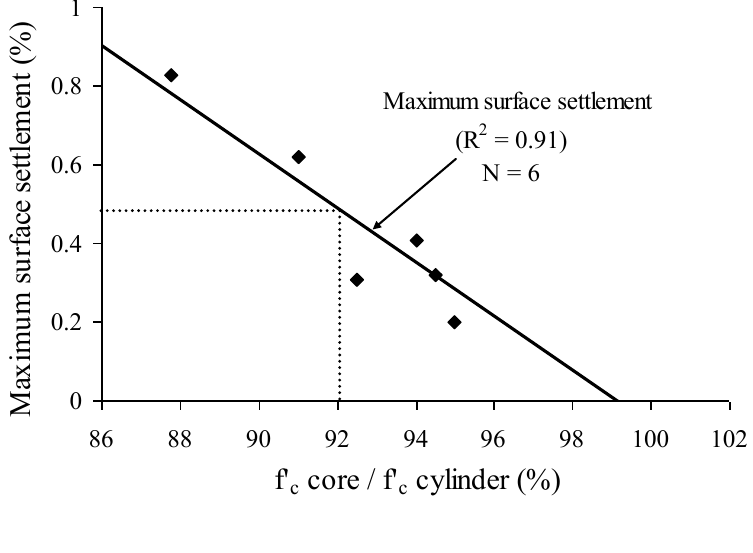
Figure 14. Relationship between relative in-place compressive strength (strength ratio relative to reference cylinder) and maximum surface settlement determined on PVC